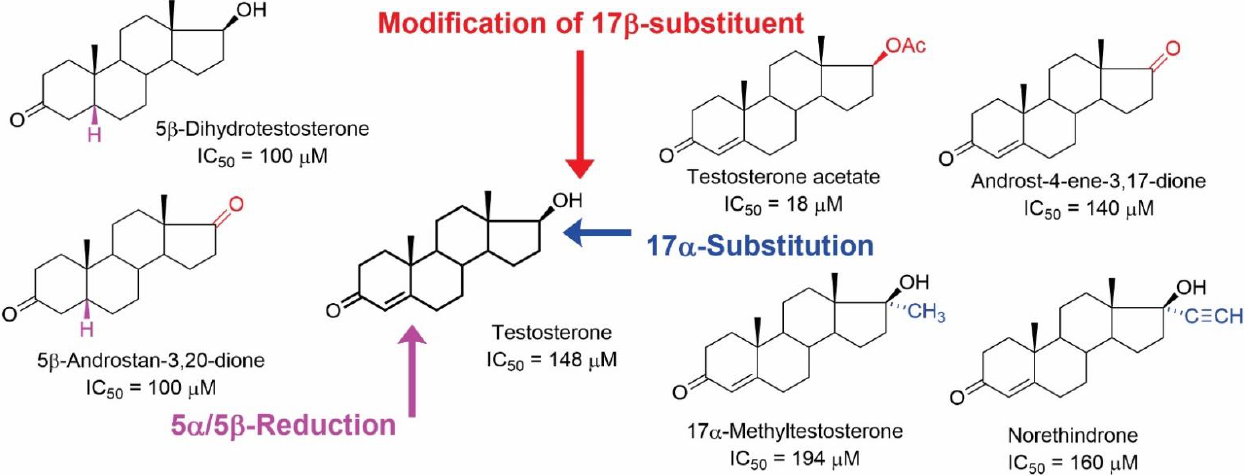
Figure 7. Structures of androstane steroids with their IC 50 values in inhibiting the [ 3 H](-)QNB binding from the study of Klangkalya and Chan [44].